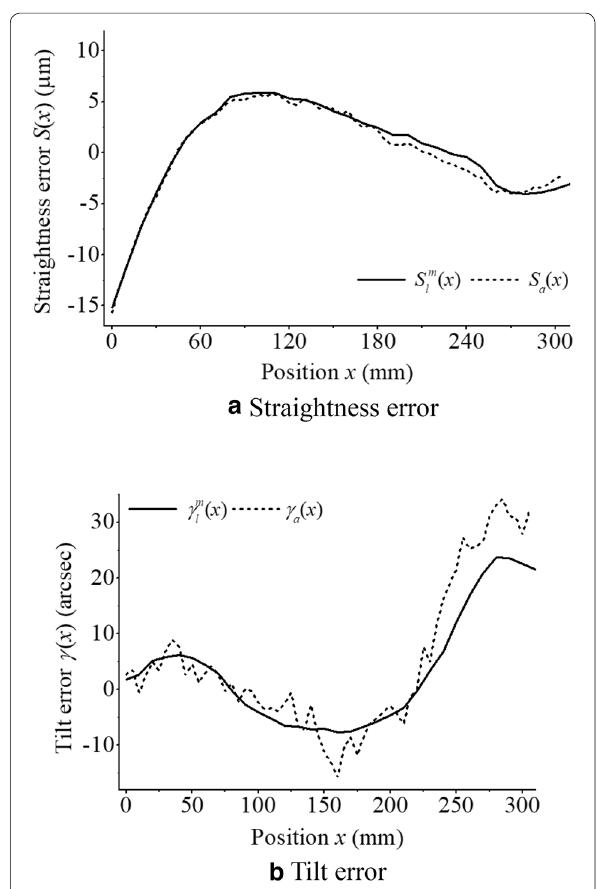
Figure 11 Comparisons of experimental results after the coordinate system OXY is